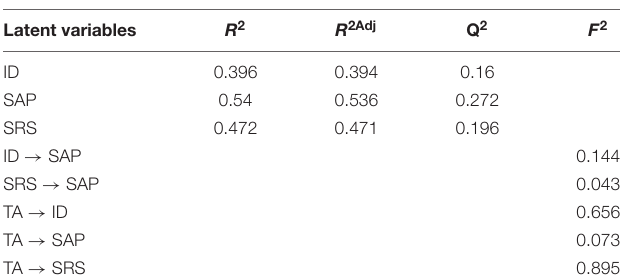
TABLE 7 | Quality